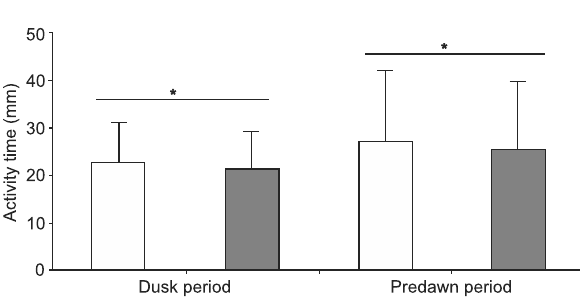
Figure 1. The foraging time of dusk (n = 63) and predawn (n = 63) periods of Tylonycteris pachypus in Longzhou County (empty col- umn) and Guiping County (grey column), Guangxi, south China. All data are expressed as Mean ± SD. *p < 0.05.